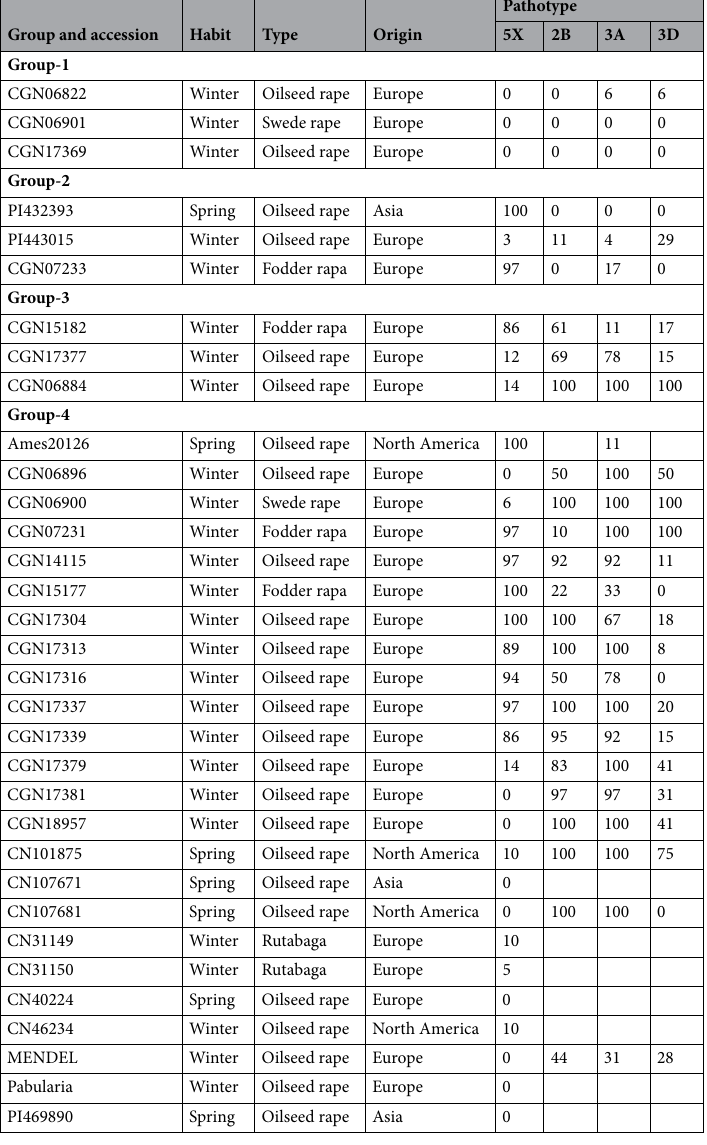
Table 1. Resistant accessions grouped based on their response (disease severity index) to inoculation with pathotypes 5X, 2B, 3A and 3D 6 of Plasmodiophora brassicae. ‘.’ Untested due to poor quality of